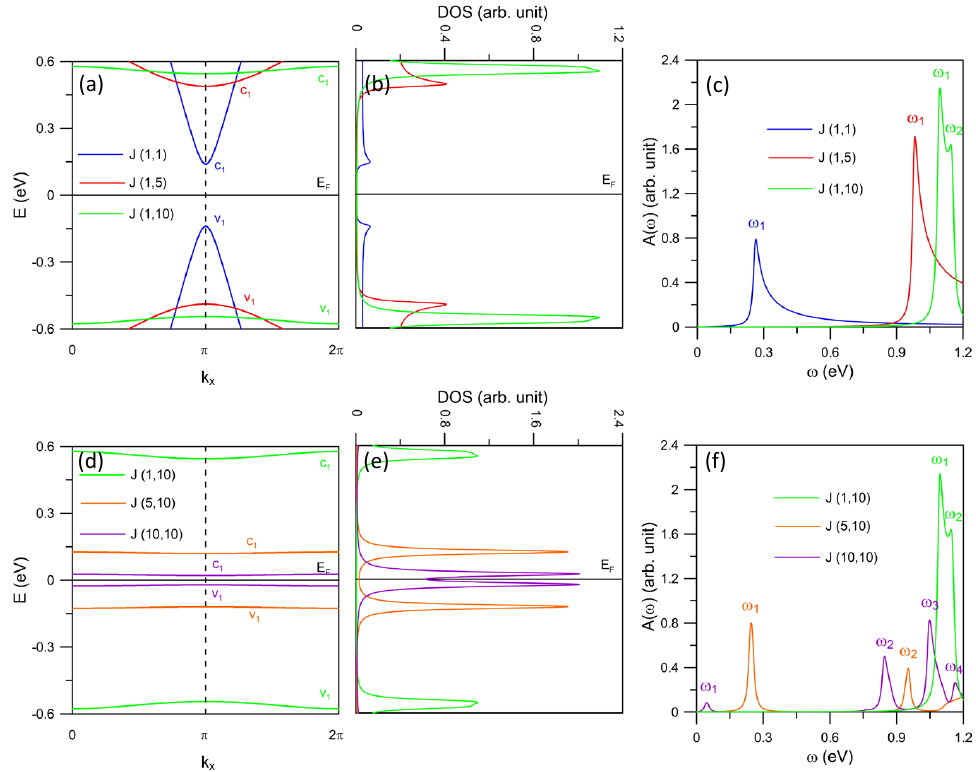
Figure 2. (color online) ( a ) Electronic band structure of J- ( n , m ) AGNRs with n = 1 and various chosen values of m , ( b ) the corresponding DOS and ( c ) the absorption spectra. Panels ( d – f ) illustrate similar plots for m = 10 and various n